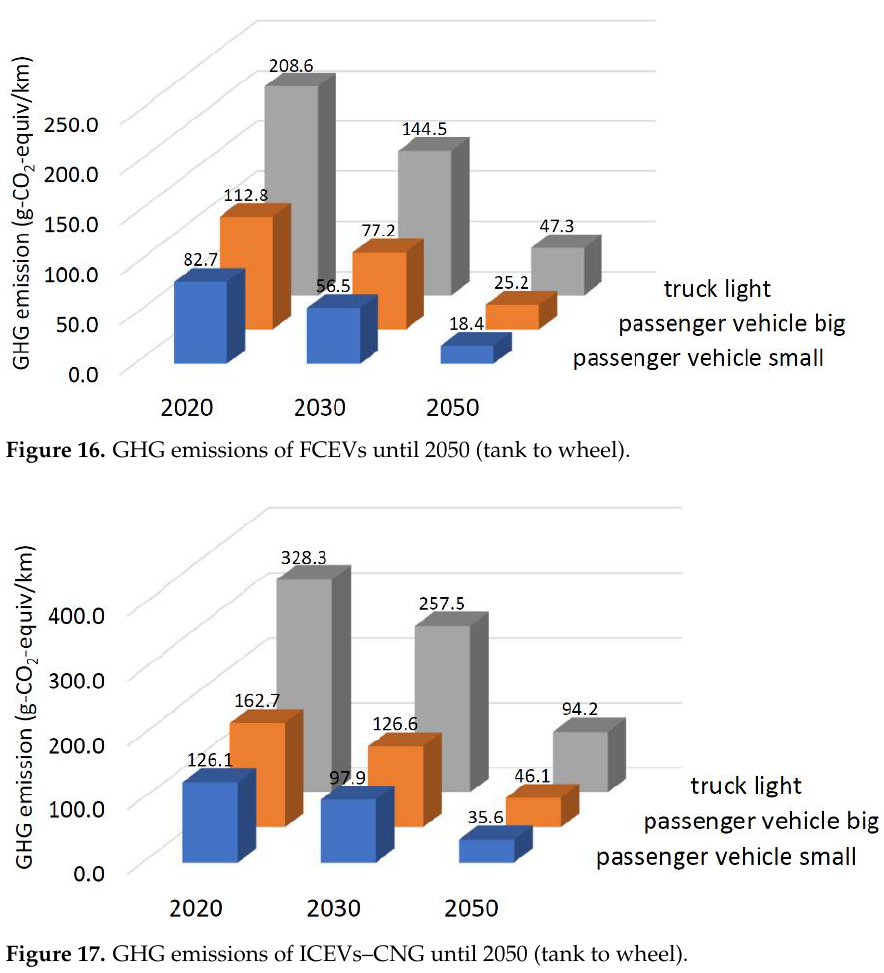
Figure 15. GHG emissions of BEVs until 2050 (tank to wheel).